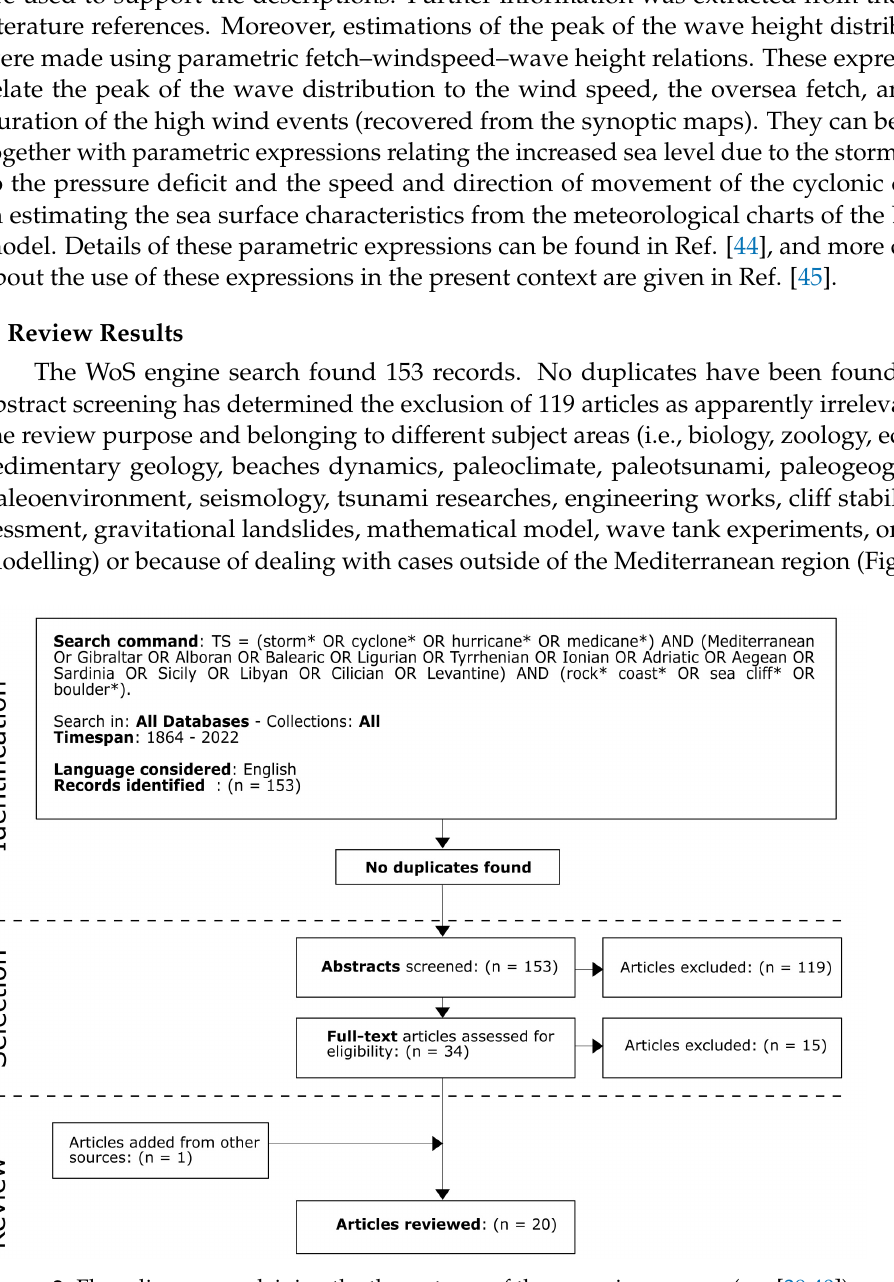
Figure 2. Flow diagram explaining the three stages of the screening process (see [39,40]). A total of 15 articles were then excluded by the full-text assessment (Appendix